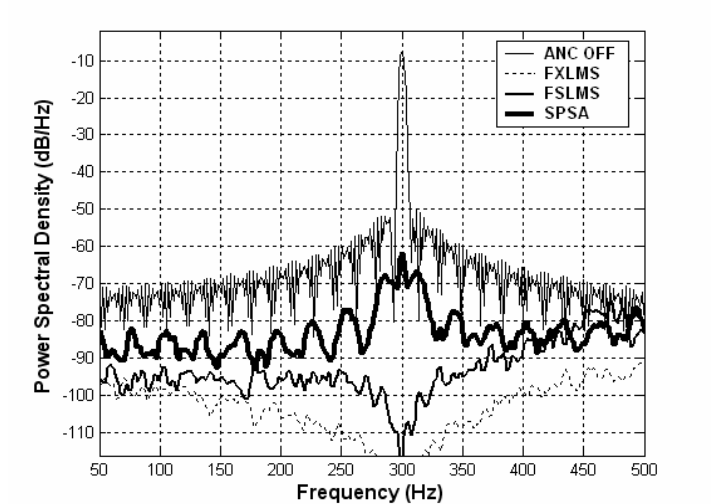
Fig. 4. The error signal spectrum for case 1.